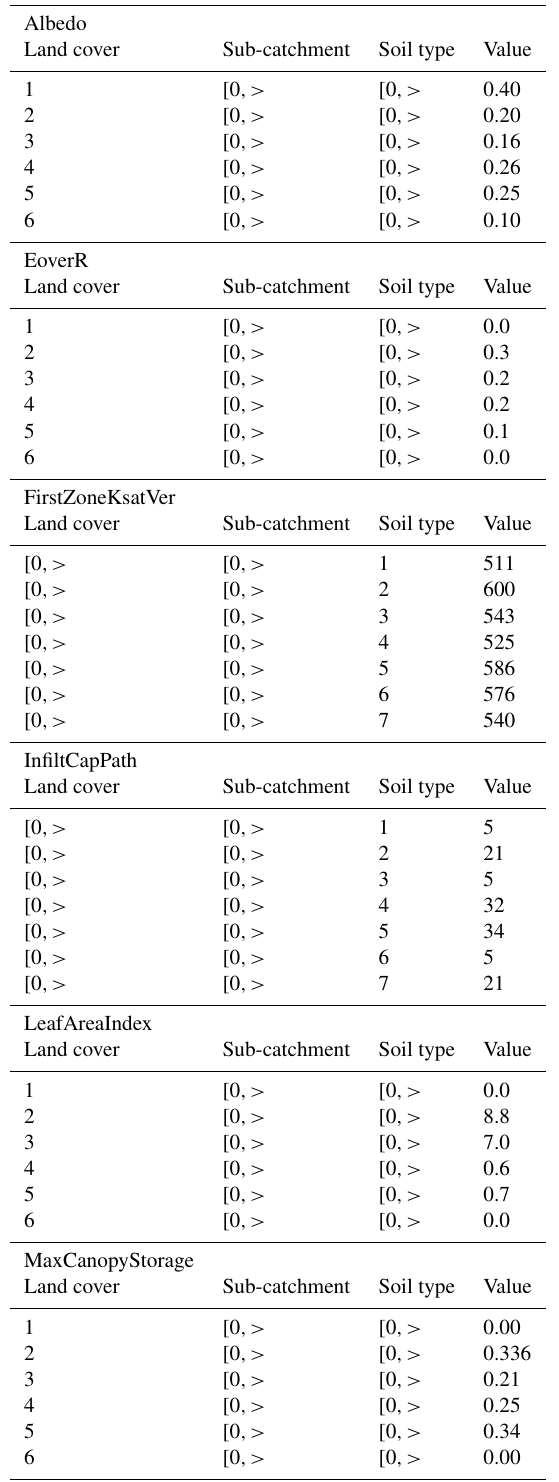
Table C1. Wflow model parameters calibrated